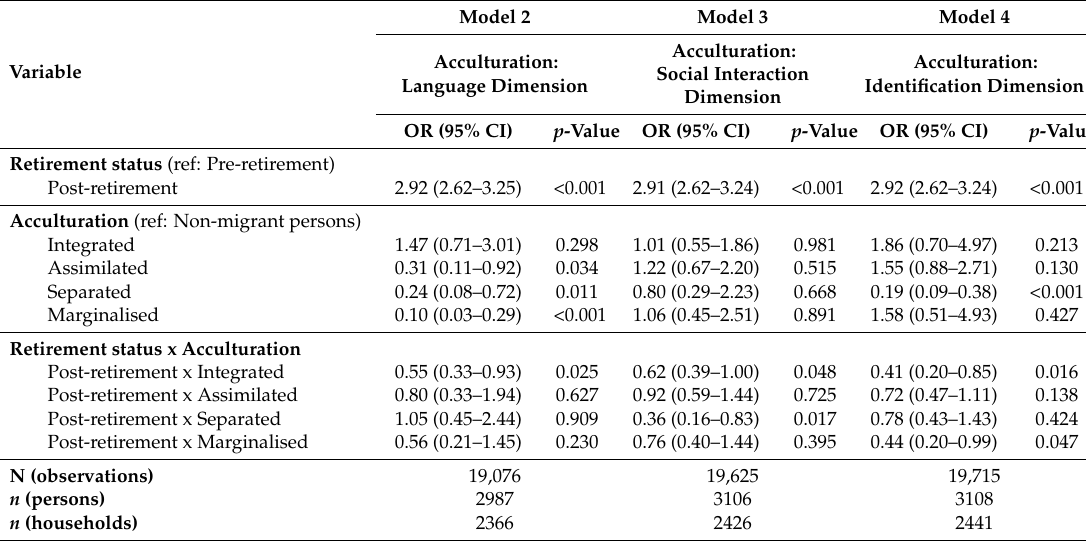
Table 3. Estimates from the multilevel logistic regression models on sports participation by different dimensions of acculturation.